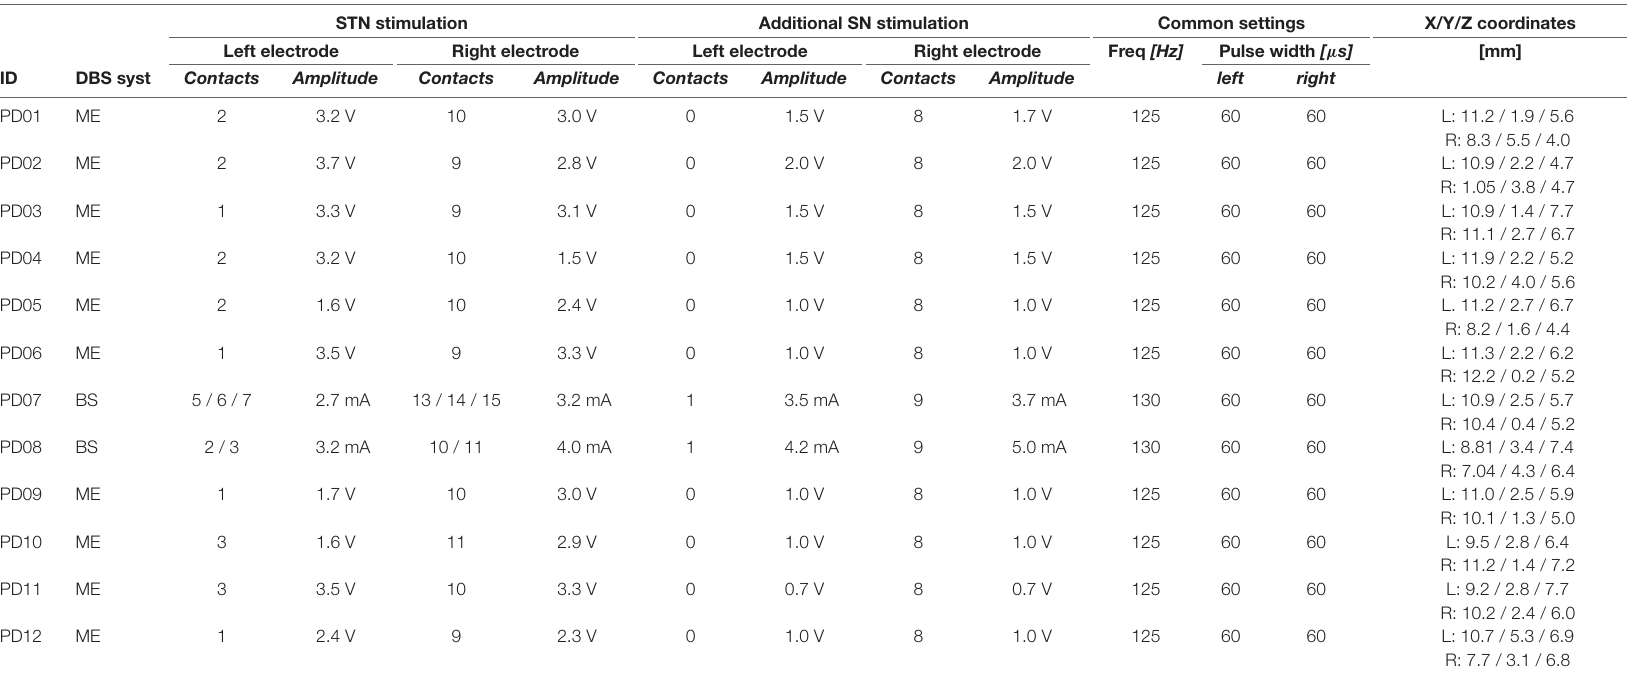
TABLE 2 | Stimulation parameters for STN and STN+SN DBS.